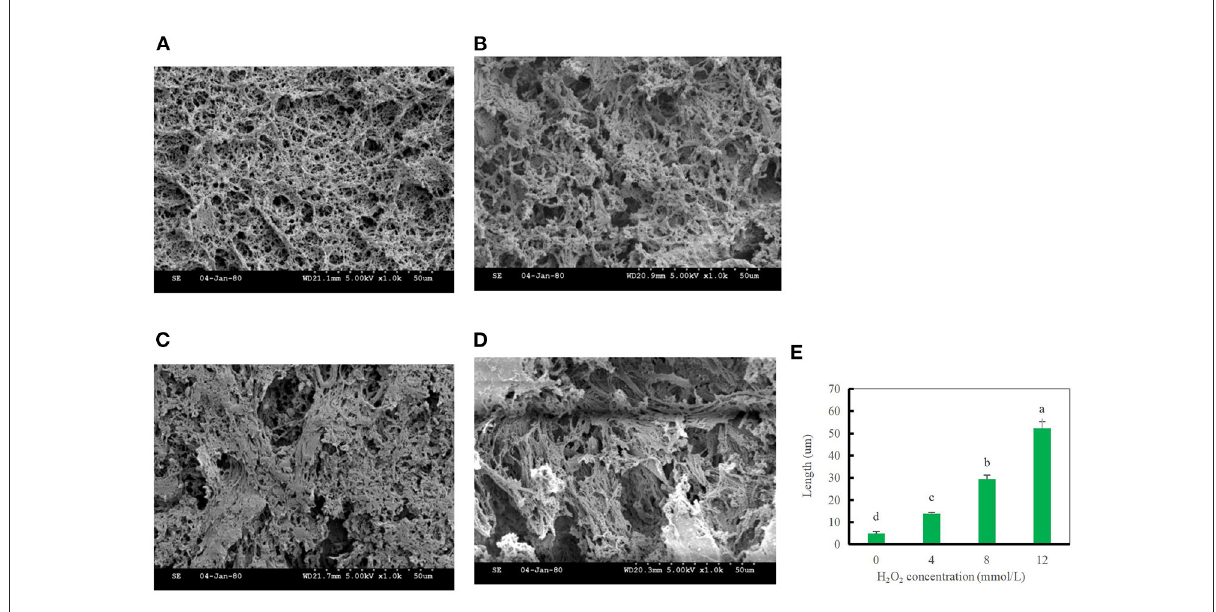
FIGURE7 Changes in the gel microstructure of duck myofibrillar protein (DMPs) gels pretreated with 0 mmol/L (A) , 4 mmol/L (B) , 8 mmol/L (C) , 12 mmol/L H 2 O 2 (D) , and changes in the pore diameter of DMPs gels (E) pretreated with various hydroxyl radicals